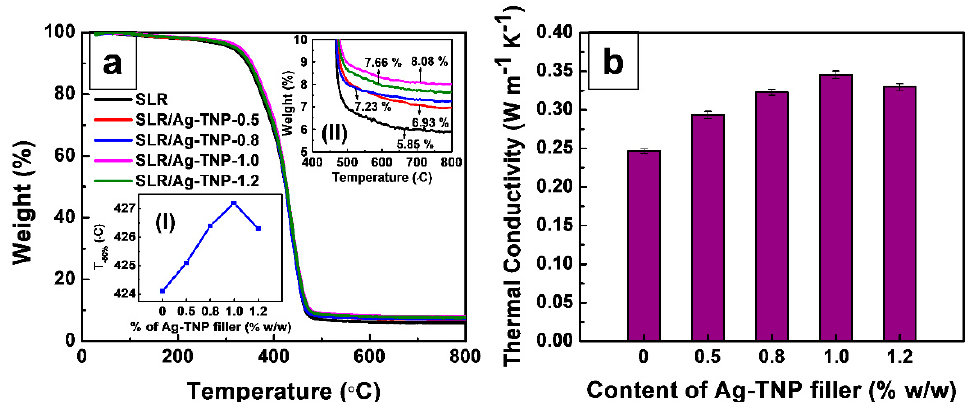
Figure 10. Thermal properties analysis of neat SLR and SLR/nanofillers nanocomposites. ( a ) comparative thermogravimetric analysis (TGA) curves of neat SLR and SLR/nanofillers nanocomposites with different concentrations, and ( b ) comparative thermal conductivity analysis of neat SLR and SLR/nanofillers nanocomposites with respect to various concentrations. The insert graphs of ( I ) and ( II ) in ( a ) illustrates the residual char wt% and variation of T -50% as a function of different % w / w of Ag-TNP, respectively.